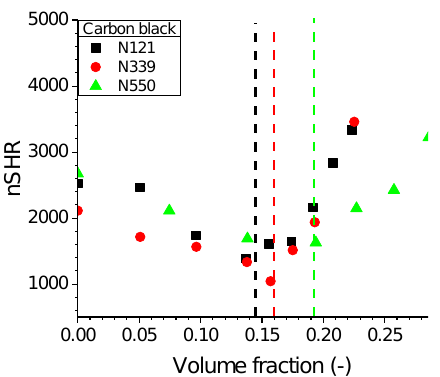
Figure 4. The normalised superharmonic resonance (nSHR) values for three carbon black grades; N121, N339, and N550 within a SSBR matrix. The dashed vertical lines represent the percolation threshold obtained by RPA for each compound.